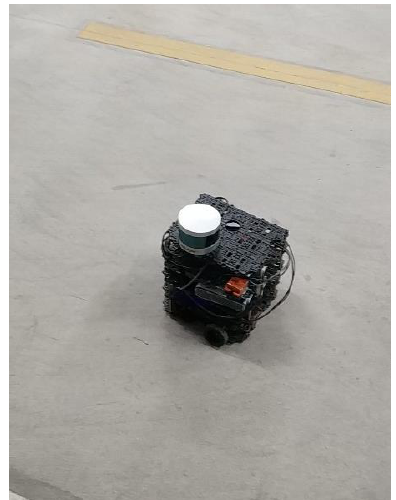
Figure 2. Data collection in underground parking lot